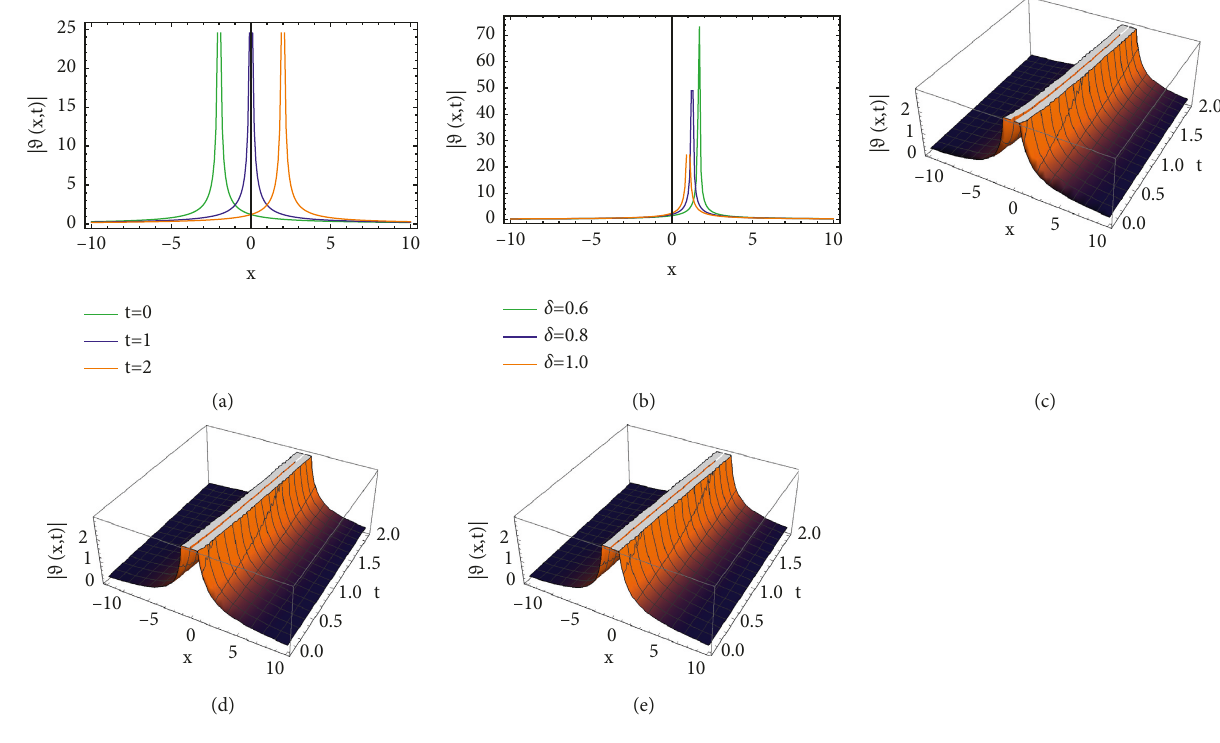
Figure 3: Wave profile of ϑ